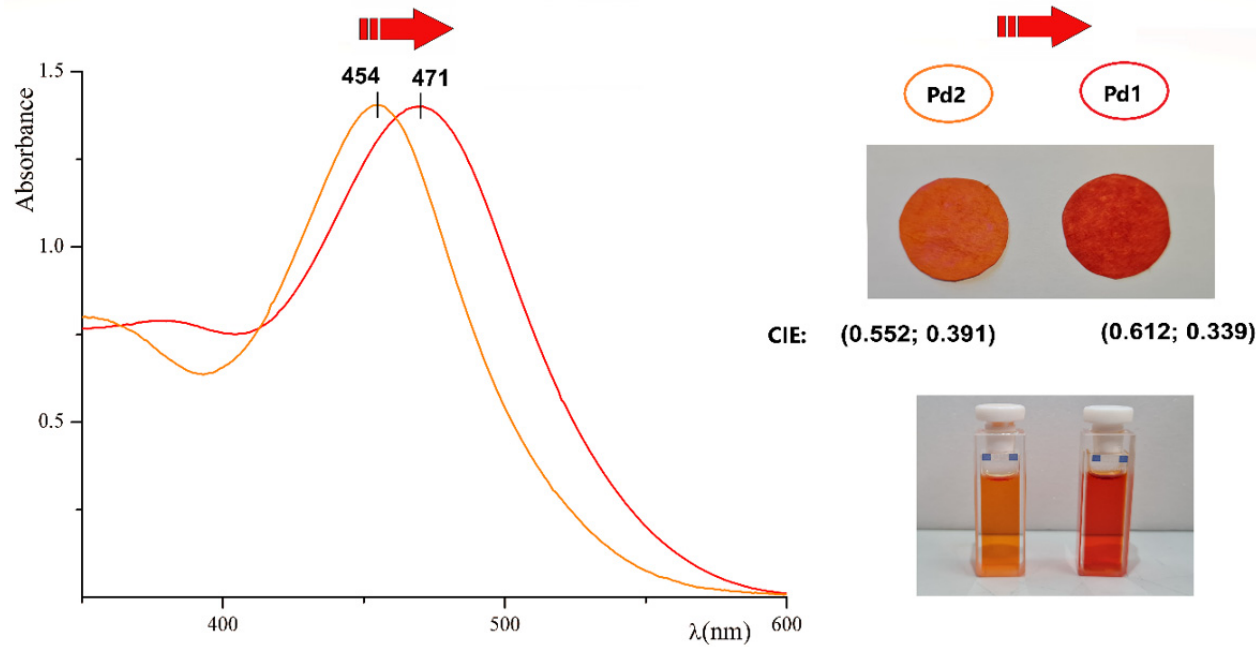
Figure 1. Absorbance curves of Pd1 and Pd2 complexes with concentration of 0.05 mM in acetone. Spectral red-shift from Pd2 to Pd1 is indicated by a red arrow. In the picture above: filter paper disks soaked with Pd1 (on the right ) and Pd2 (on the left ), with concentration of 5 mM in acetone, show a marked colour difference. The CIE colour space coordinates are reported. In the picture below: solutions of Pd1 (on the right ) and Pd2 (on the left ) used to record the spectra.